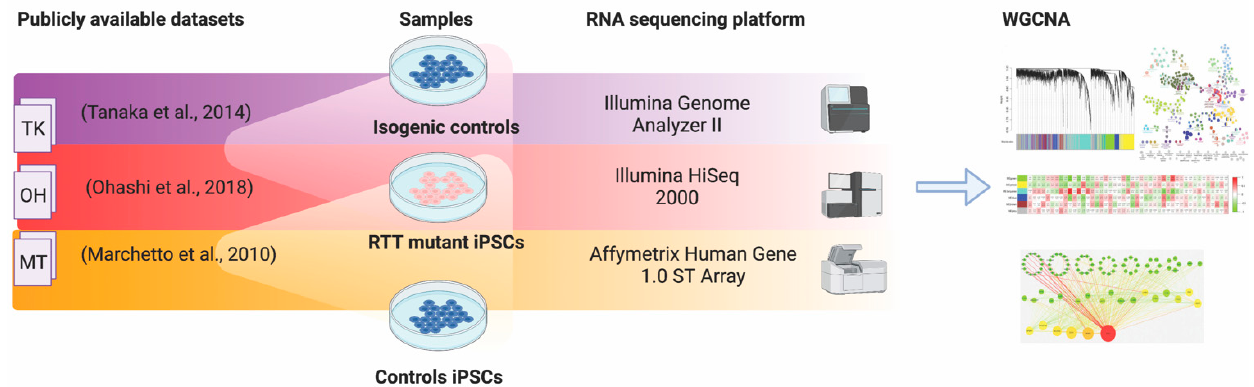
Figure 1. Source of RNA-sequencing datasets, sequencing platform and methodology of data analysis using Weighted Gene Correlation Network analyses (WGCNA) to identify relevant modules of genes and subsequent preservation analy- sis between